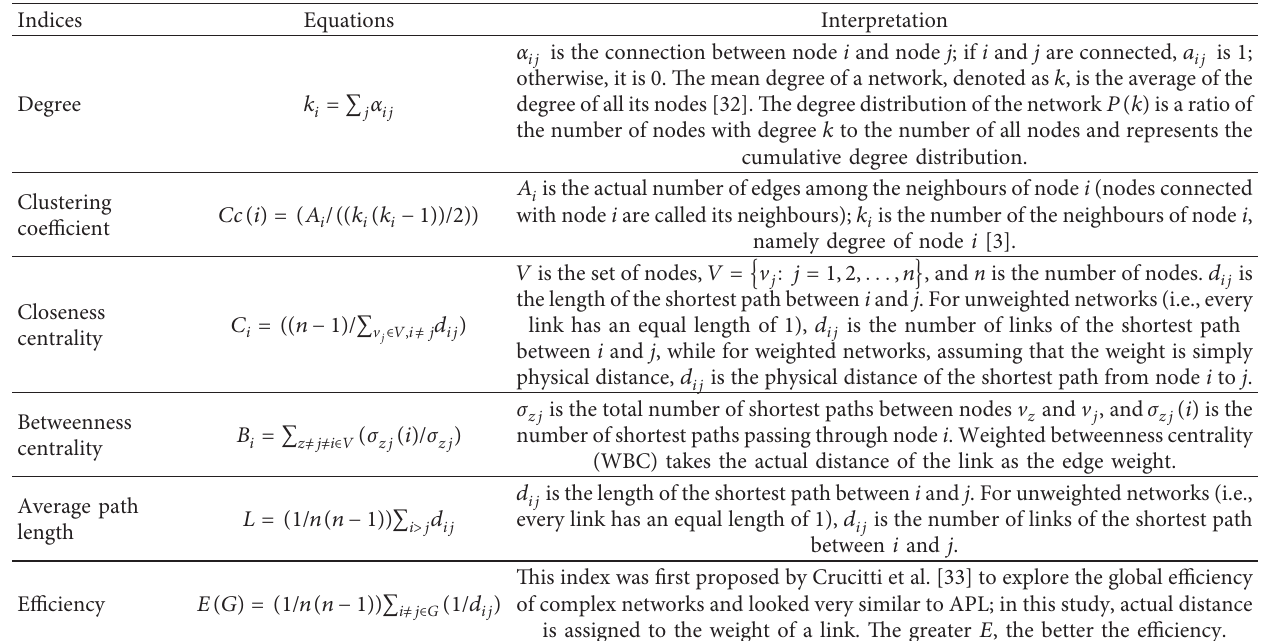
Table 2: Six indices used for analysing urban road networks.